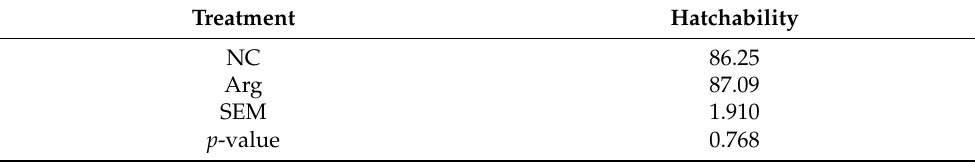
Table 2. Effects of in ovo feeding of L-arginine on the hatchability of slow-growing chickens. Treatment Hatchability NC 86.25 Arg 87.09